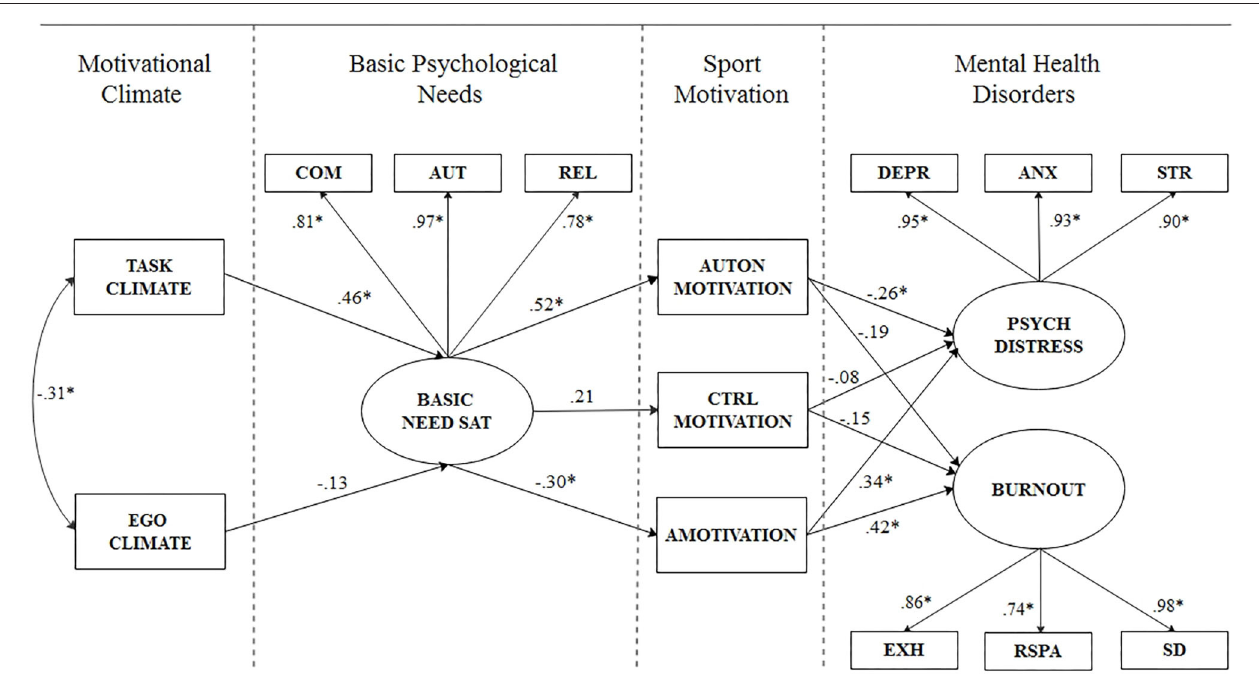
FIGURE 1 | Standardized path coefficients from the SDT structural models. BASIC NEED SAT, basic needs satisfication; PSYCH DISTRESS, psychological distress; COM, competence; AUT, autonomy; REL, relatedness; AUTON, autonomous; CTRL, controlled; DEPR, depression; ANX, anxiety; STR, stress; EXH, exhaustion; RSPA, reduce sense of personal accomplishment; SD, sport